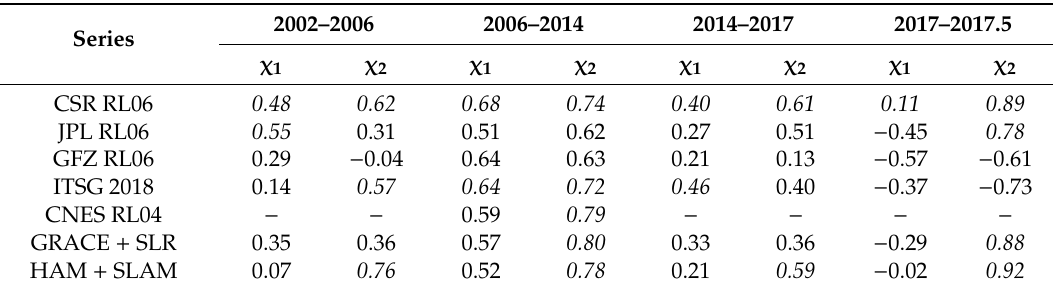
Table 3. Correlation coe ffi cients between GAO and GSMAM, between GAO and GRACE + SLR, and between GAO and HAM + SLAM for four considered time periods. Before computing the values, linear trends were removed from the series. Note that CNES RL04 was included only for the period 2006–2014. The highest values of correlations are italicized.